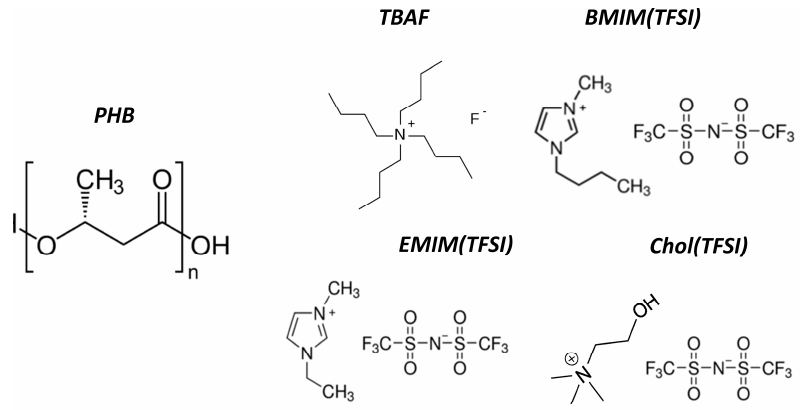
Figure 1. The chemical structure of the polymeric matrix is shown on the left side of the picture, while the other additives (ILs and organic salt) are shown on the right side.